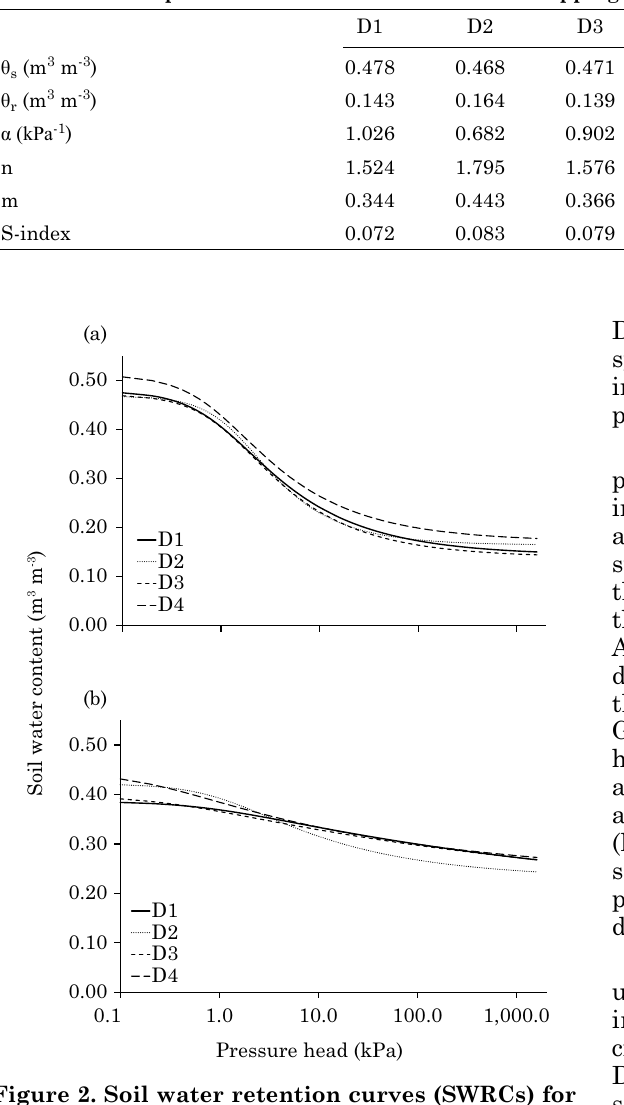
Figure 2. Soil water retention curves (SWRCs) for soil under continuous arable cropping system (a) and natural bush fallow system (b) for depths D1 (0-5 cm), D2 (5-10 cm), D3 (10-15 cm), and D4 (15-20